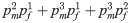
Comparison of shares of couple types in simulation outcomes and the ESS.The simulation outcomes are based on the calibrated simulation model. Confidence bands show +/- 1 standard deviation around the mean of the simulation outcomes based on 50 independent simulation runs. Weighting has been applied to the ESS data. Expected values are calculated based on the IIASA/VID data that we used for generating model inputs (see S1 Appendix for details). The calculation is based on the simplifying assumption that all men/women in a given ten-year birth cohort would marry somebody who was born in the same cohort. Based on this simplifying assumption, if marriage would occur completely at random the expected shares of hypergamic couples can be calculated as pm2pf1+pm3pf1+pm3pf2, the expected shares of homogamic couples can be calculated as pm1pf1+pm2pf2+pm3pf3, and the expected shares of hypogamic couples can be calculated as pf2pm1+pf3pm1+pf3pm2, where pfs and pms refer to the shares of women and men in the ordered educational categories (s) 1 = ‘no education’/ ‘primary education’, 2 = ‘secondary education’, and 3 = ‘tertiary education’.